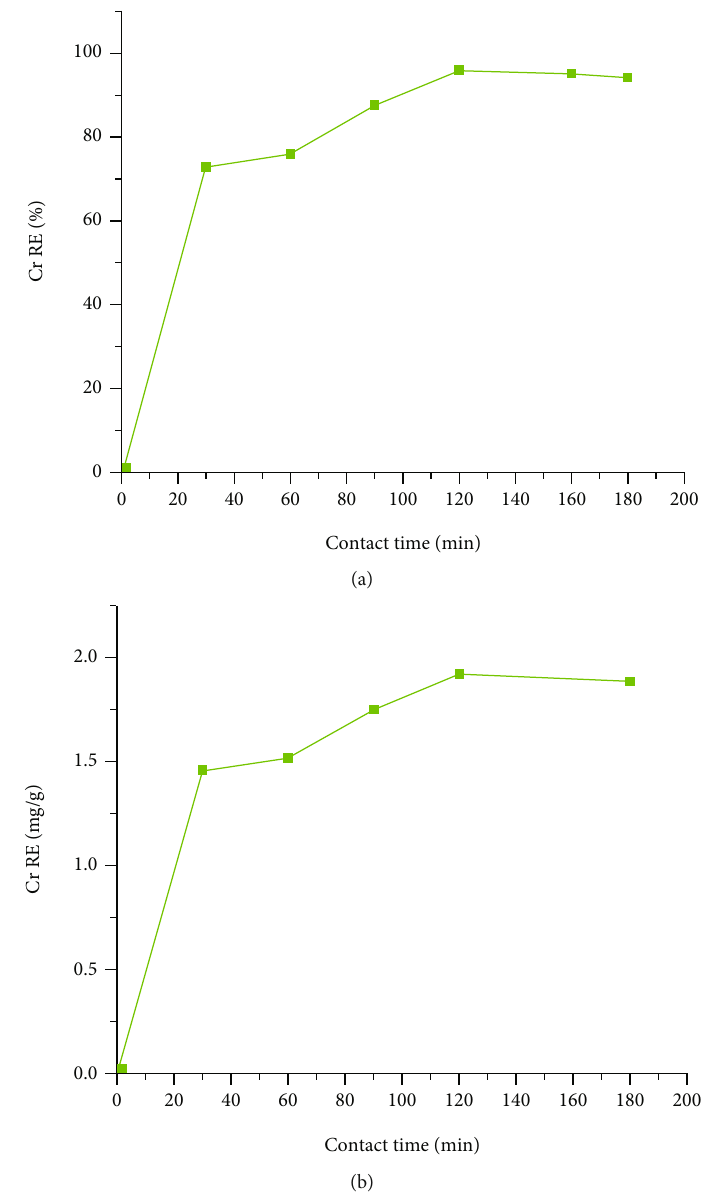
Figure 6: Contact time e ff ects on Cr (a) % RE and (b) mass adsorption e ffi ciency (mgg -1